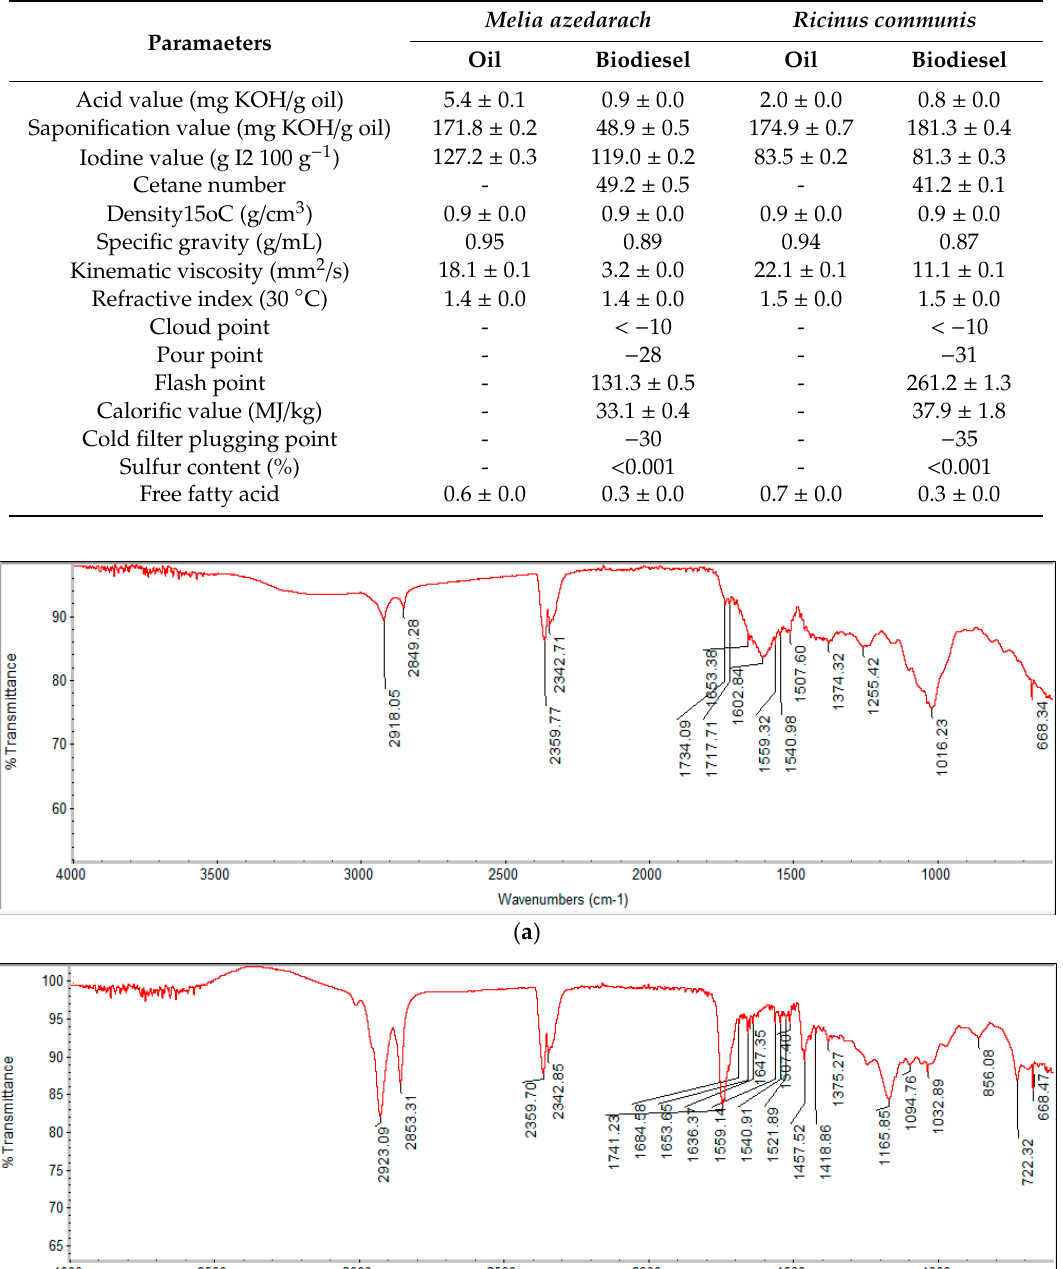
Table 2. Physico-chemical characteristics of oil and fuel properties of biodiesel.